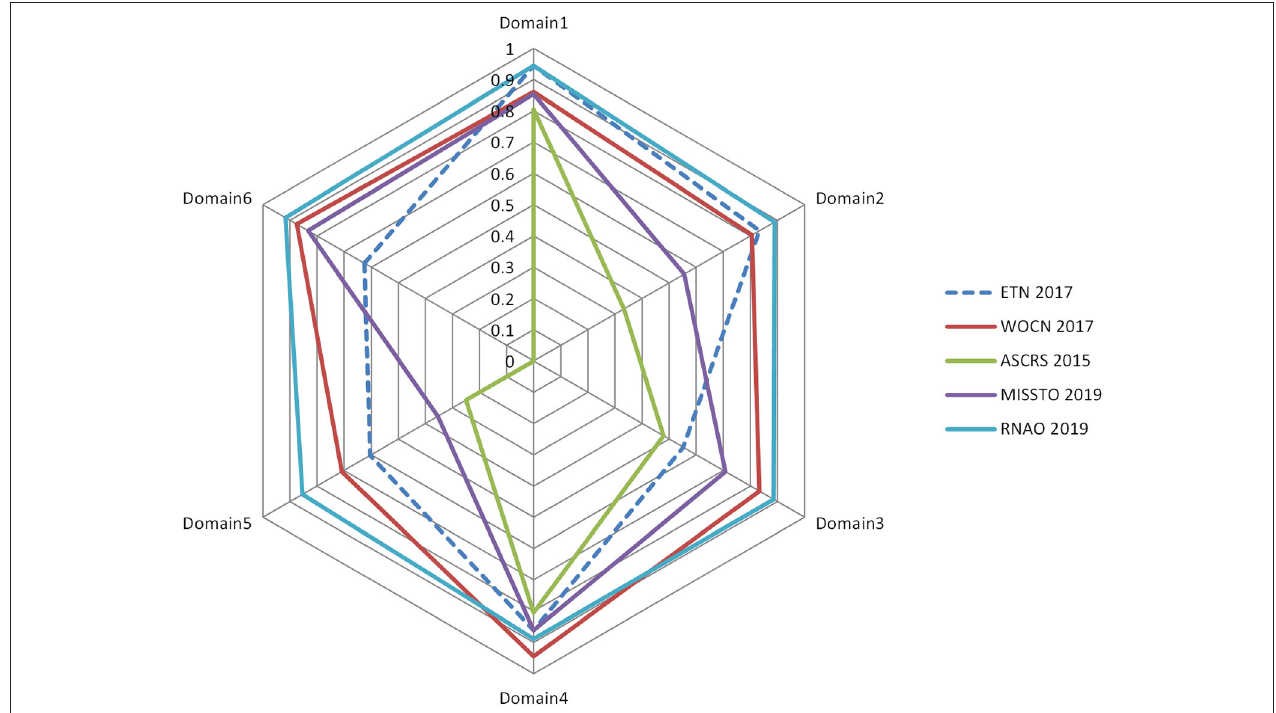
FIGURE 2 | Radar map of the AGREE II final standardized domain scores for the five included ostomy